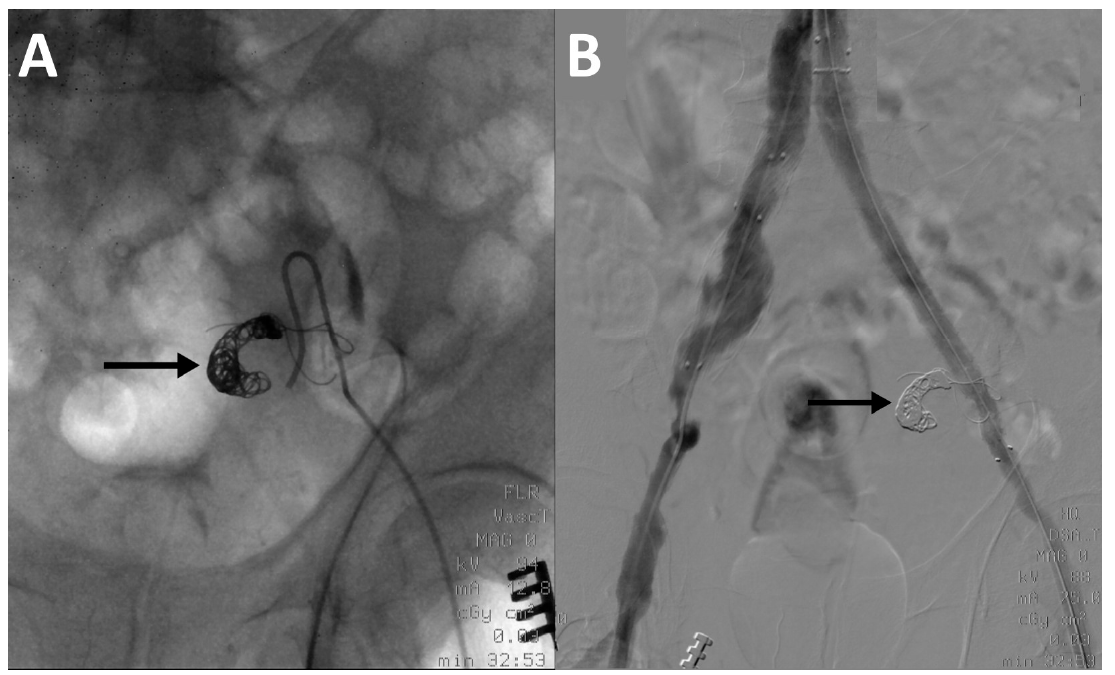
Figure 1. ( A ) Intraprocedural fluoroscopy image of a left ipogastrigc artery embolization with coils (arrows) using a Simmons-shape catheter. ( B ) Final digital subtraction angiography image at the end of the EVAR procedure showing complete exclusion of the left ipogastrigc artery.